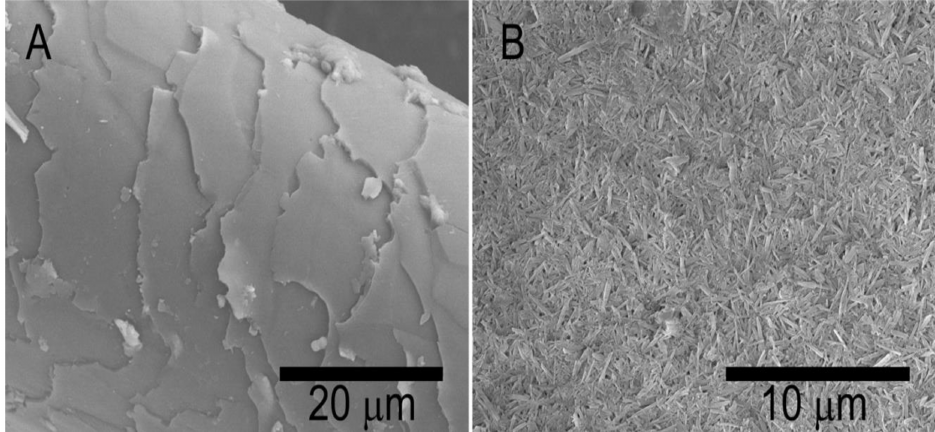
Figure 8. SEM images of pristine ( A ) and wax pretreated ( B ) goat hair coated with halloysite